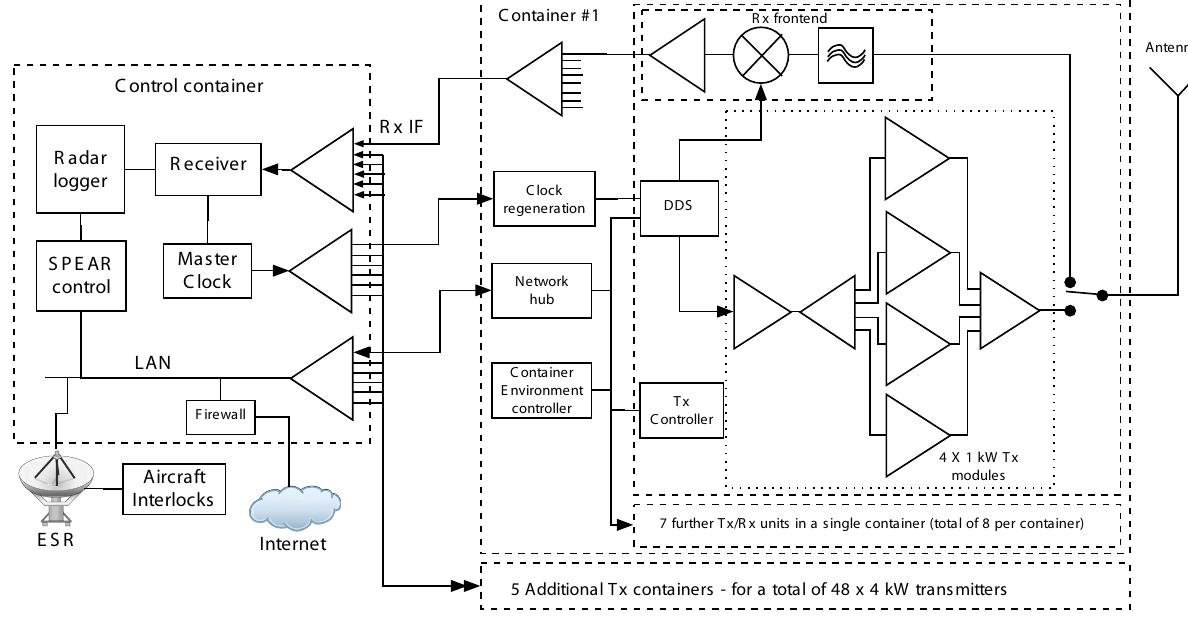
Fig. 3. A block diagram of the SPEAR system illustrating the distributed transmit and receive configuration.